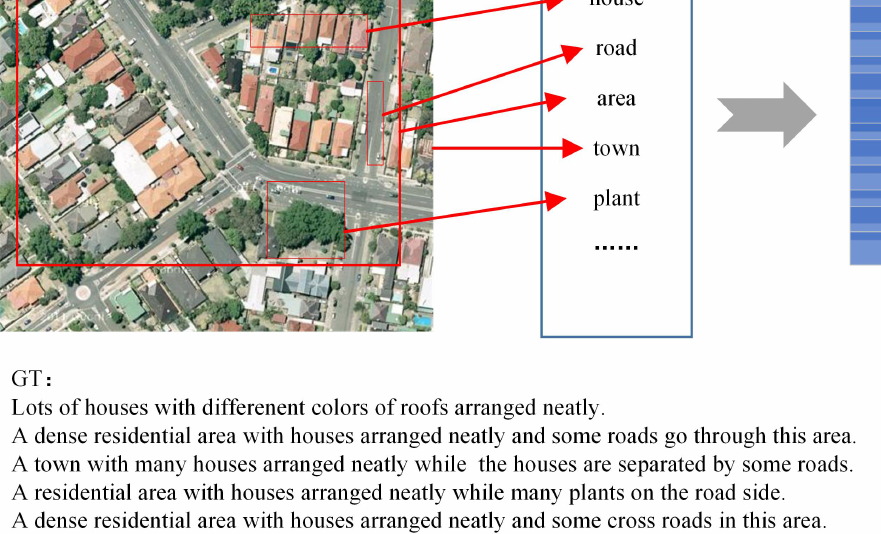
Figure 3. Overview of the proposed entity feature acquisition of remote sensing image f a ttr